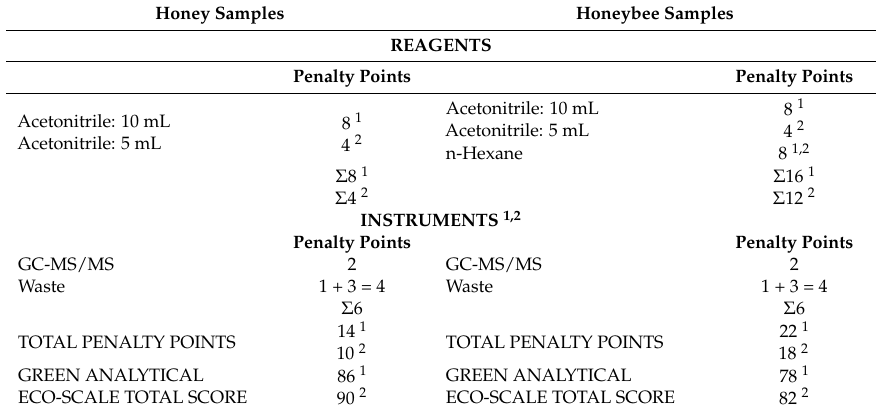
Table 2. The penalty points for pesticide residues determination in honey and honeybee samples using GC-MS/MS. Honey